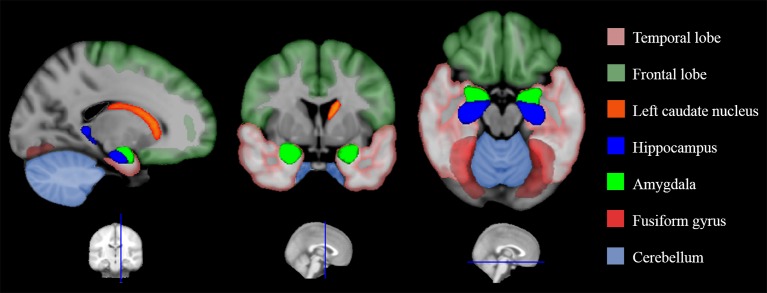
Structural alterations in the social brain found in preterm individuals. This is a graphic representation of a summary of the studies reviewed in Table 3. Colored areas highlight brain regions involved in processing socio-emotional stimuli that have been shown to display structural alterations in very preterm samples.